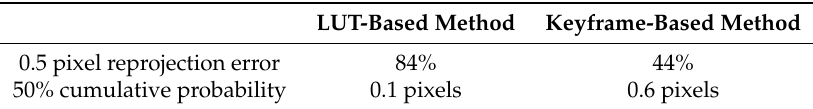
Figure 8. The empirical cumulative distribution function of the reprojection error. Table 3. Comparison of reprojection